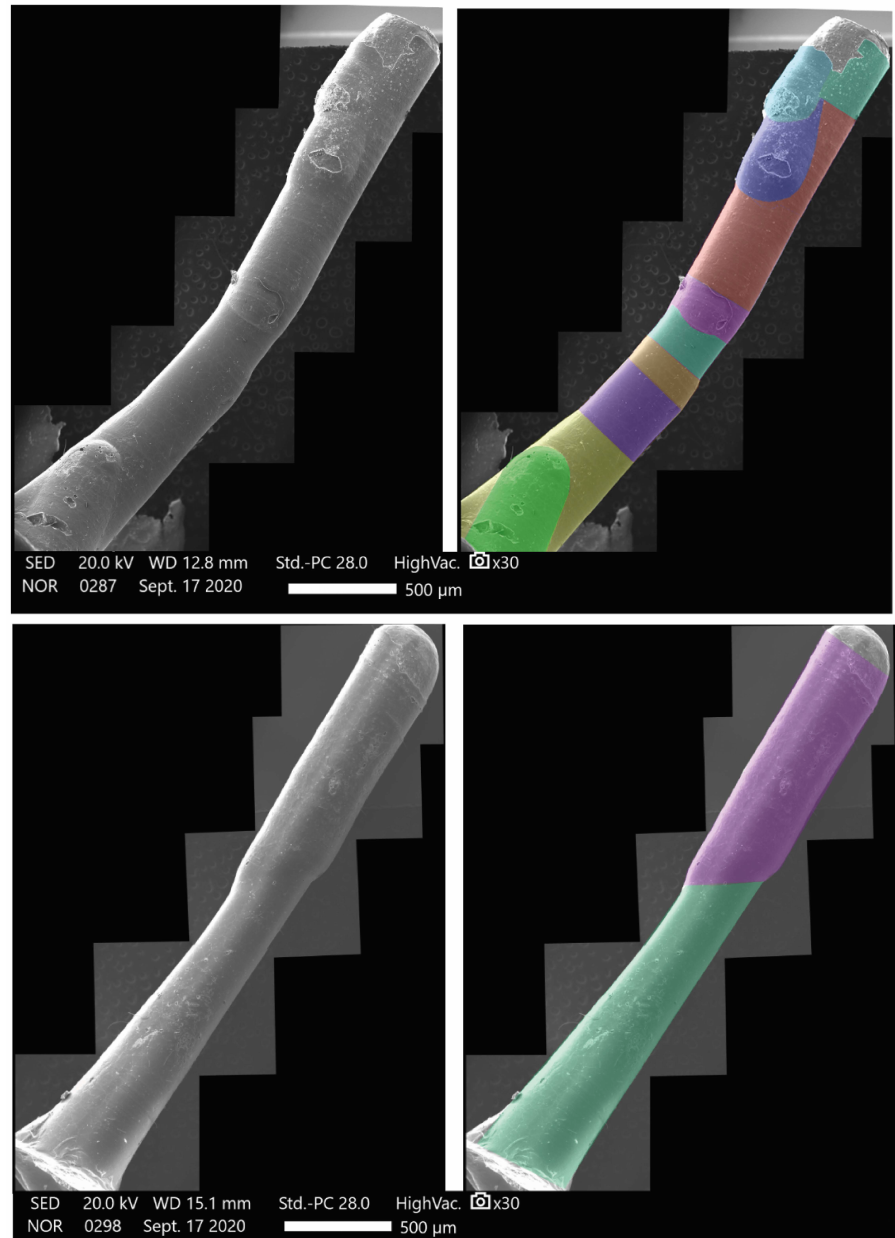
Figure 14: Montage of SEM images of the perforation casts of rock crystal beads SM-02-77 (top) and SM-02-80 (bottom). The perforation of SM-02-77 shows ten different perforation axes, some of which show a strong offset from the perforation axis (green and light blue). The bead SM-02-80 shows only two perforation